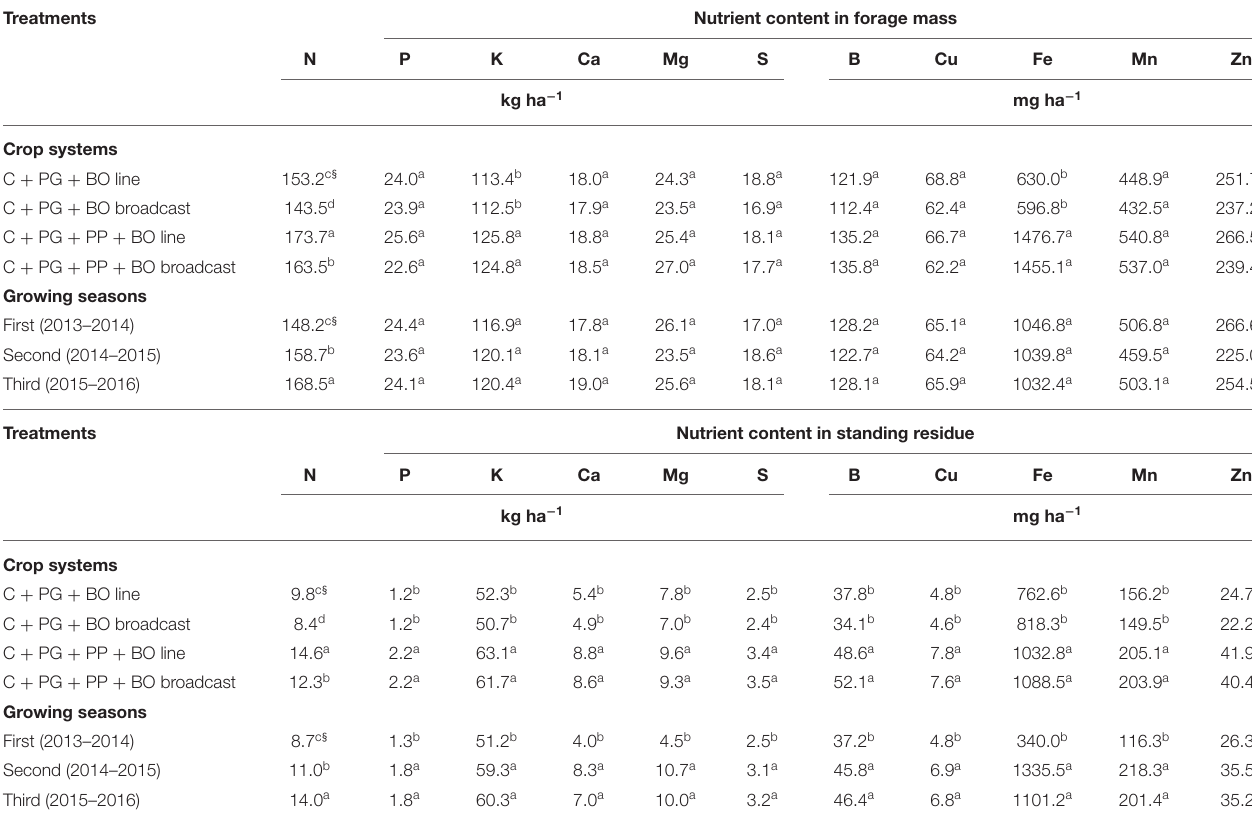
TABLE 6 | Nutrient content in forage mass and in standing plant residue of corn to silage intercropped with palisade grass (C + PG) and with palisade grass and pigeon pea (C + PG + PP) with black oat (BO) oversown in lines and broadcast compared to corn, palisade grass, and pigeon pea monoculture in three growing seasons.